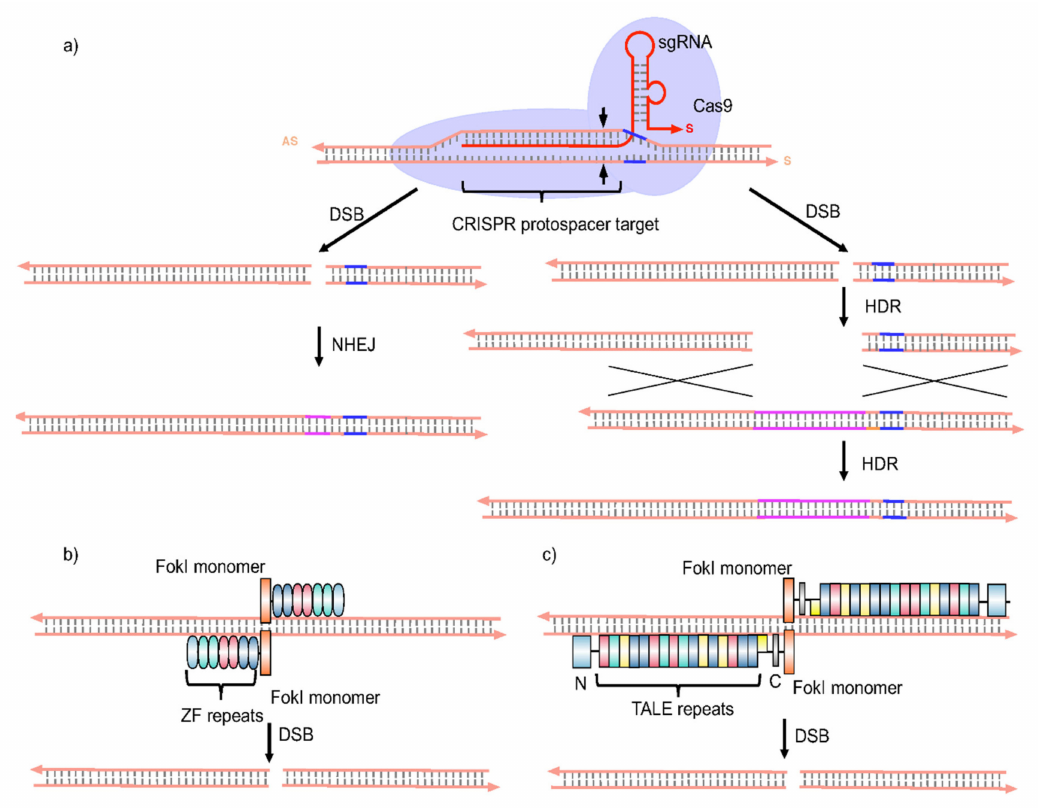
Figure 6. Schematic representations of gene editing technologies. ( a ) Class 2 clustered regularly interspaced short palindromic repeat (CRISPR) systems are part of an adaptive immune system in bacteria Due to comparative simplicity and adaptability, CRISPR has rapidly become a popular genome engineering approach. CRISPR-associated endonuclease (Cas protein, typically Cas9 from S. pyogenes ) is a nuclease capable of creating targeted double-strand breaks (DSBs) when directed to a given DNA locus by means of a guide RNA (gRNA or sgRNA, red strand in figure). The sgRNA is a short stretch of synthetic RNA composed of a sca ff old sequence at its 3 (cid:48) -end for binding to Cas9 and a user-defined sequence (20–22 nts) at its 5 (cid:48) -end, for binding to the AS strand of a selected CRISPR protospacer target in DNA. This CRISPR protospacer target should be immediately adjacent to a protospacer adjacent motif (PAM) (typically 5 (cid:48) -NGG in the DNA S strand, blue strand region in figure). The CRISPR / Cas9 system operates when Cas9 and the sgRNA form a ribonucleoprotein complex. The sgRNA sca ff old sequence interacts with surface-exposed positively-charged grooves on Cas9, and the resulting complex then undergoes a conformational change that enables the sgRNA protospacer to zip-bind with the AS strand of the CRISPR protospacer target sequence in a 3 (cid:48) to 5 (cid:48) direction, starting with the gRNA seed sequence (first 8–10 nts). Assuming seed sequence / AS strand complementarity, the sgRNA will then continue to anneal to the end, thereby enabling the Cas9 functional endonuclease domains (RuvC and HNH) to undergo a second conformational change that leads to a double-strand break (DSB) (~3–4 nts upstream of the PAM sequence). The resulting, highly selective DSB is then repaired by one of two general repair pathways; (1) The e ffi cient but error-prone non-homologous end joining (NHEJ), (2) The less e ffi cient but high-fidelity homology-directed repair (HDR). The NHEJ repair pathway causes small nucleotide insertions or deletions (indels) at the DSB site. In most cases, indels result in frameshift mutations leading to premature stop codons within the targeted gene and may result in amino acid deletions, insertions and / or protein loss-of-function at the level of translation. Accordingly, the NHEJ repair pathway can be used to disrupt the open reading frame of a gene and generate a knock-out